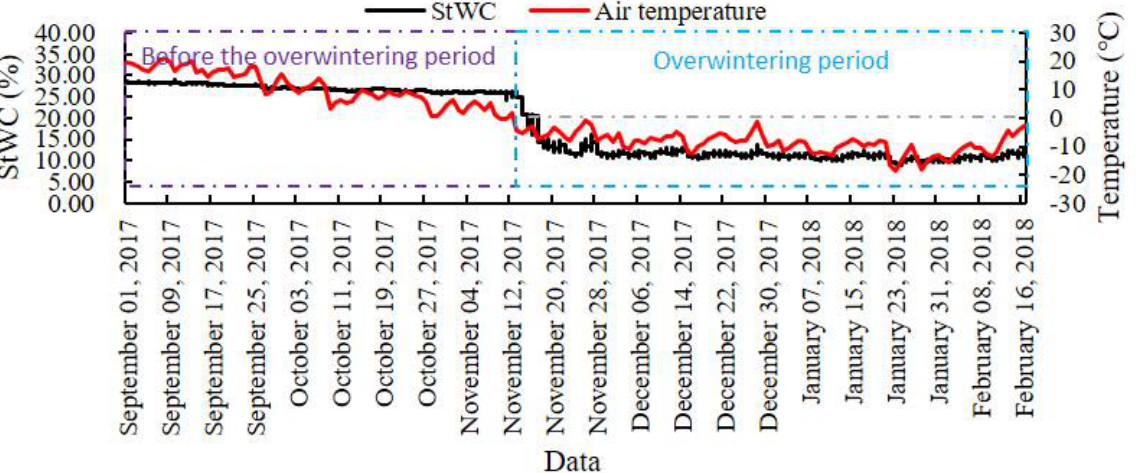
11 of 16 Figure 8. StWC changes in normal irrigation with water and without irrigation with water: ( a ) StWC of Malus micromalus Makino . ( b ) Diurnal range of StWC for Malus micromalus Makino . ( c ) Diurnal mean of StWC for Malus micromalus Makino . 3.6. StWC Changes in Pinus tabuliformis Carriere during the Overwintering Period When Experiencing Freeze-Thaw Stress Figure 9 shows changes in StWC of Pinus tabuliformis Carriere before and after entering the overwintering period. Before the overwintering period, the ambient